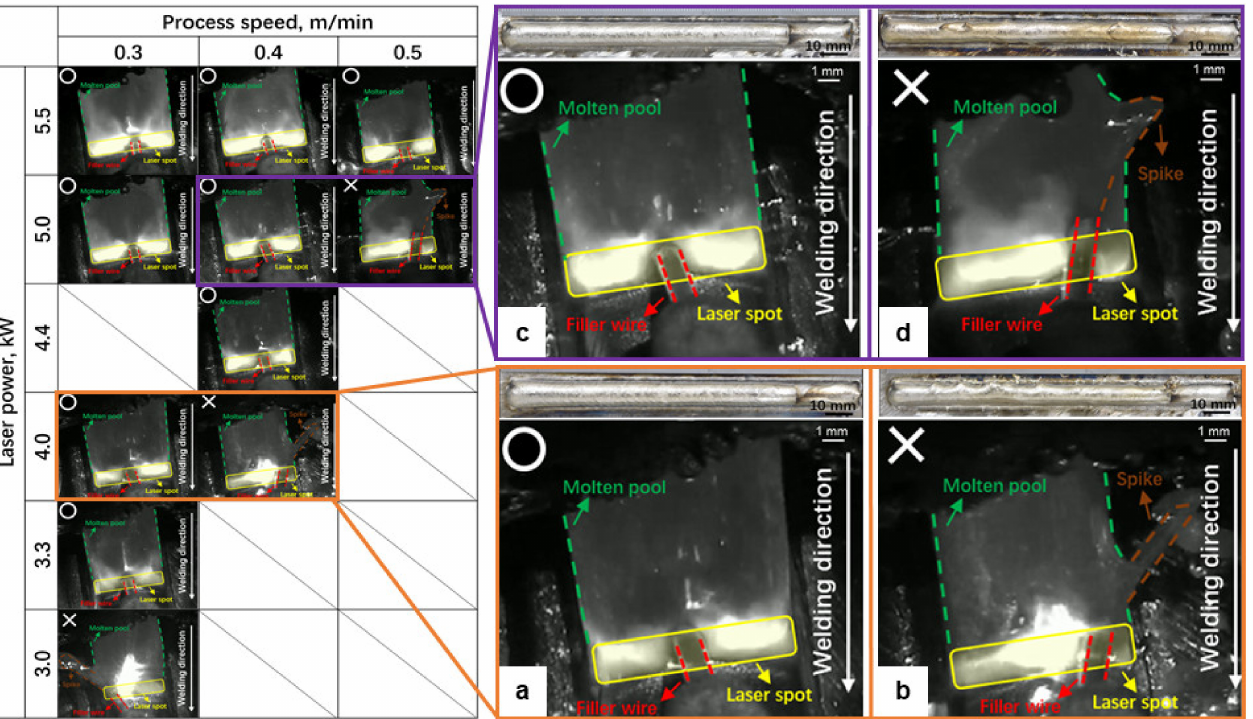
Figure 14. High-speed images during processing for various combinations of process speed and laser power using fixed wire feeding rate of 20 m/min: ( a ) P = 4.0 kW, V p = 0.3 m/min, ( b ) P = 4.0 kW, V p = 0.4 m/min, ( c ) P = 5.0 kW, V p = 0.4 m/min, and ( d ) P = 5.0 kW, V p = 0.5